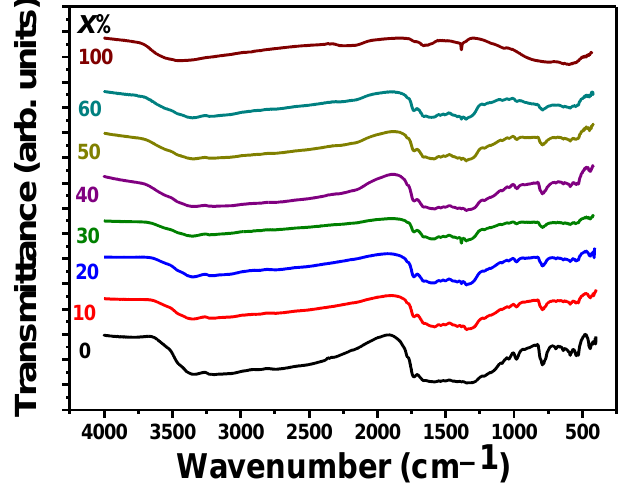
Figure 1. FTIR spectra for PbO- x %Al 2 O 3 composites. Table 1. FTIR band assignments of PdO- x %Al 2 O 3 composites.